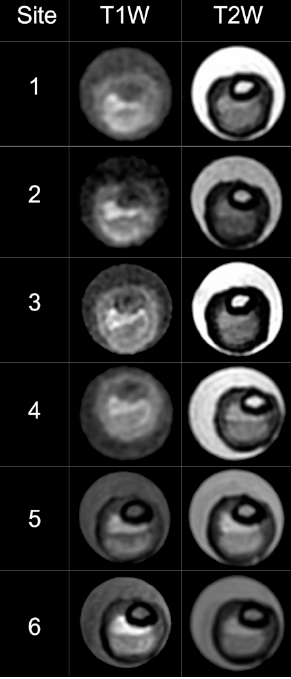
Figure 1. Cross-sectional T1 and T2 high-resolution MRI images of a phantom model acquired on six Chinese sites. The scans are in the same sequence of sites as in Table 3. Phantom images scanned